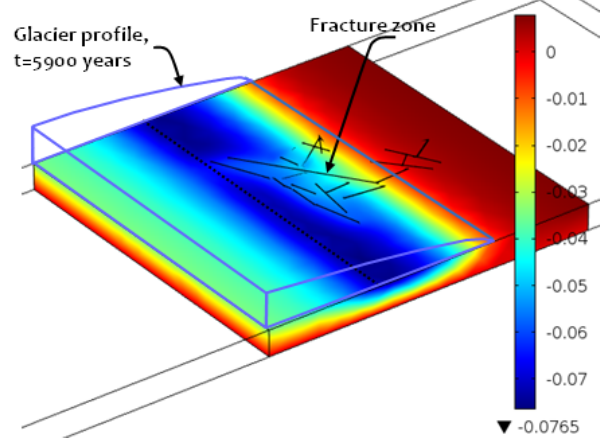
Figure 12. Vertical displacement [m] of the rock mass with frac- tures at time 5900 years. The rock is subjected to spatially non- uniform fluid pressure and compressive